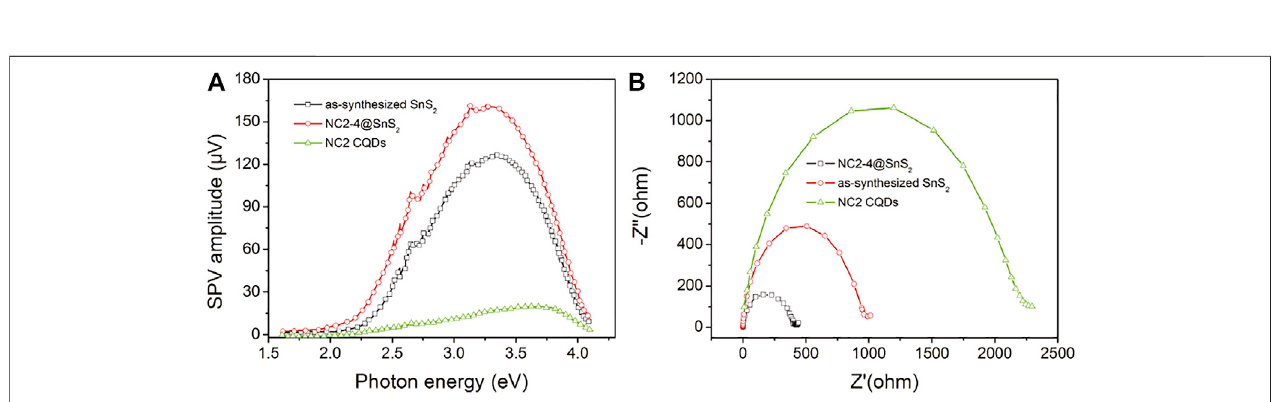
FIGURE 7 | SPV (A) and EIS Nynquist plots (B) of NC2-4@SnS 2 , NC2 CQDs, and as-synthesized SnS 2 nanoparticles.